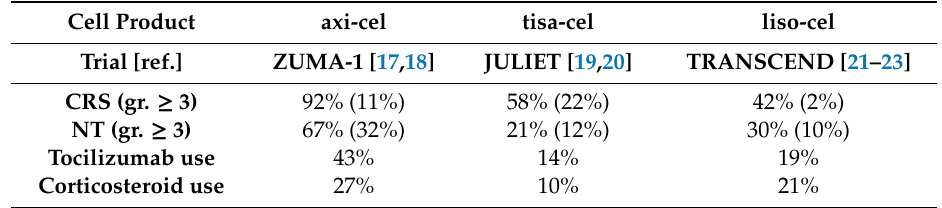
Table 2. Toxicity data of CD19-targeted CAR-T-cell therapies axi-cel, tisa-cel, and liso-cel in NHL. Cell Product axi-cel tisa-cel liso-cel Trial [ref.] ZUMA-1 [17,18] JULIET [19,20] TRANSCEND [21–23] CRS (gr. ≥ 3) 92% (11%) 58% (22%) 42% (2%) NT (gr. ≥ 3) 67% (32%) 21% (12%) 30% (10%) Tocilizumab use 43% 14% 19% Corticosteroid use 27% 10%